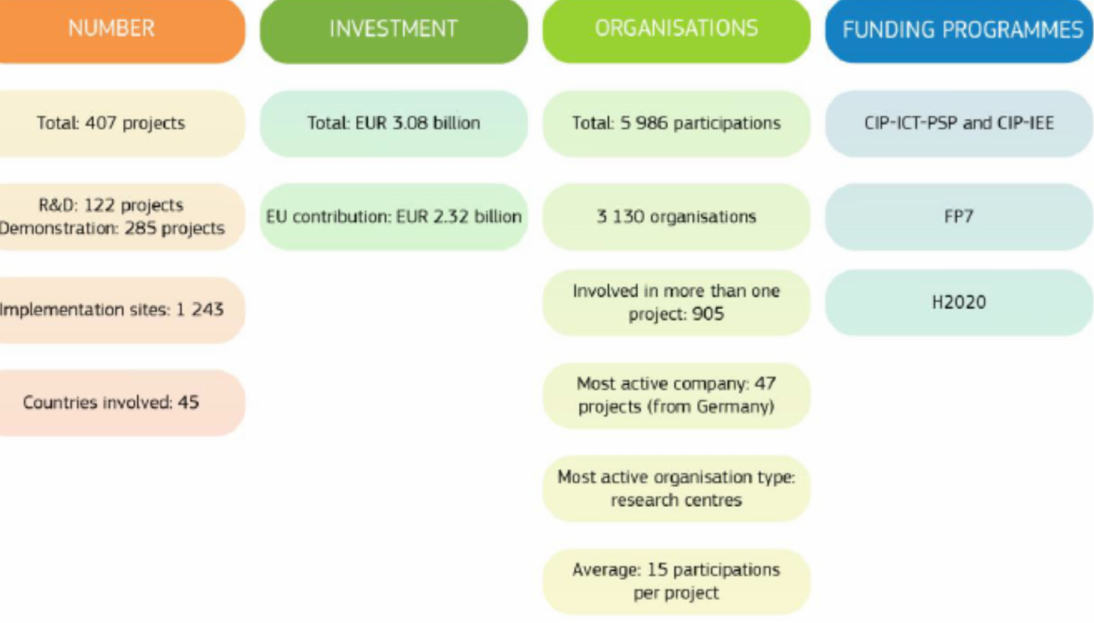
Figure 4. Smart grid projects in Europe, as extracted from